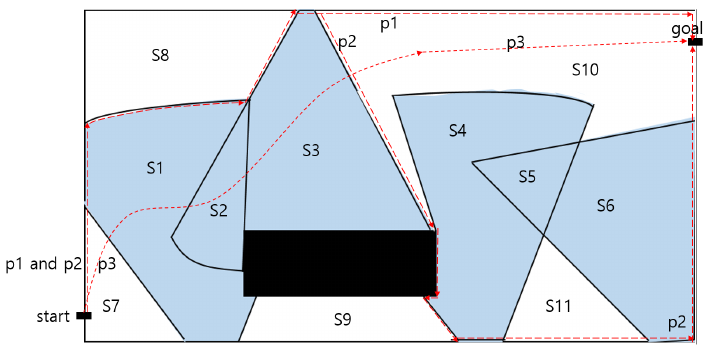
Figure 6. An example of P (red dotted lines) and ˜ P .